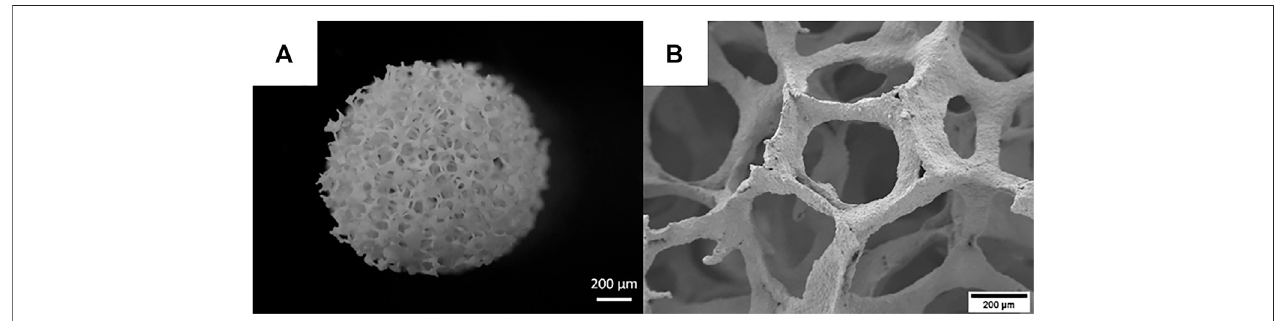
FIGURE 1 | Optical microscope (A) and SEM (B) images of sintered 45S5 BG